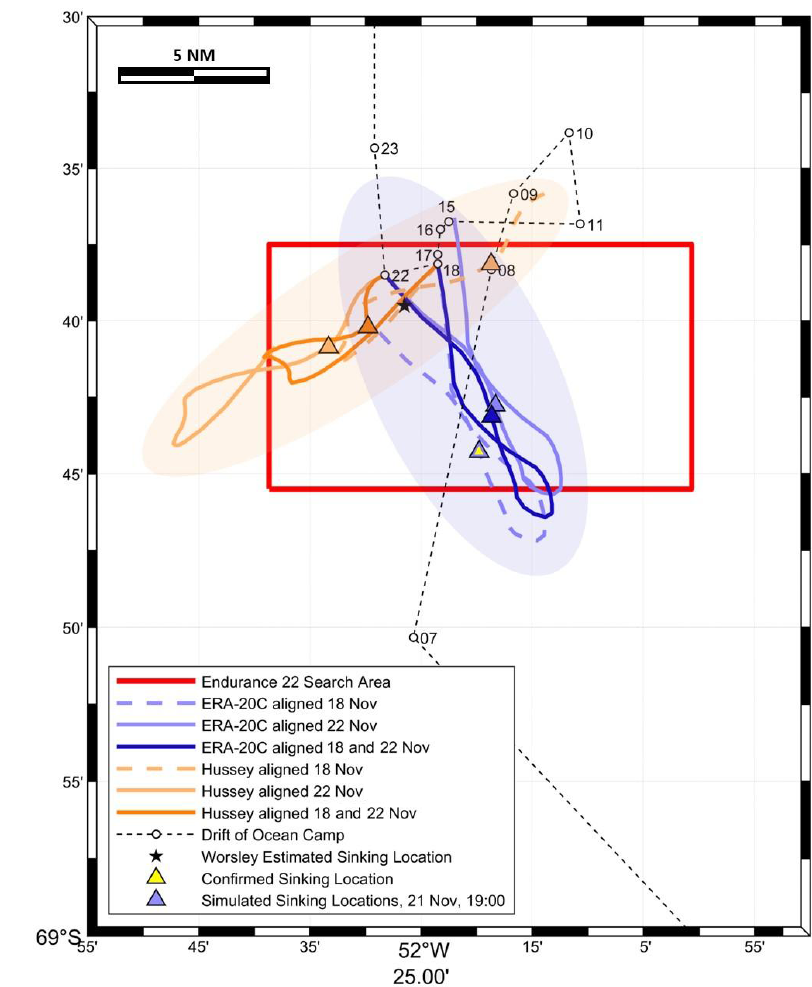
Figure A3. Case 2 reconstructed drift tracks and sinking sites using ERA-20C reanalysis (blue) and Hussy’s meteorological observations (orange). Case 2 is an idealised case, where the ERA-20C simulated sinking position is forced to coincide with the actual sinking location by adjusting model parameter values (note the coincident sinking location triangles). The required parameters are a wind factor of 1.85% and a turning angle of 17.5 ◦ . Coloured ellipses show approximate uncertainty regions associated with the respective dataset.